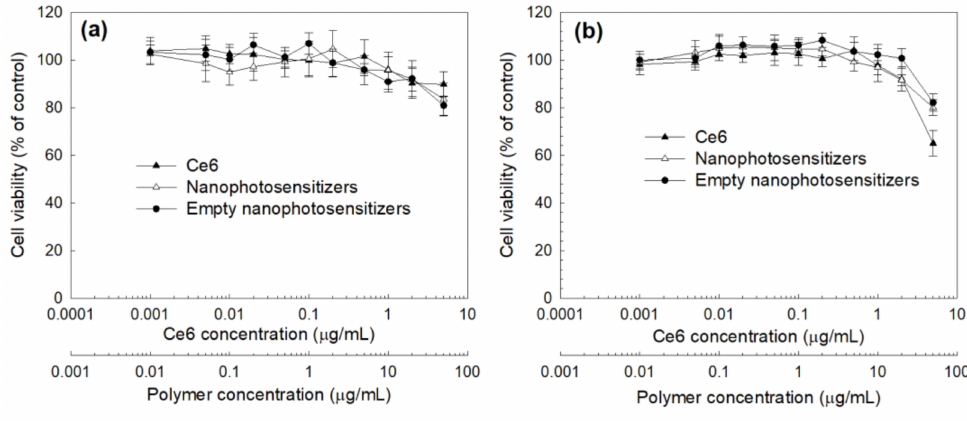
Figure 5. Dark toxicity of the Ce6 alone, nanophotosensitizers and empty nanophotosensitizers against CCD986SK human skin fibroblast cells ( a ) and HeLa human cervical carcinoma cells ( b